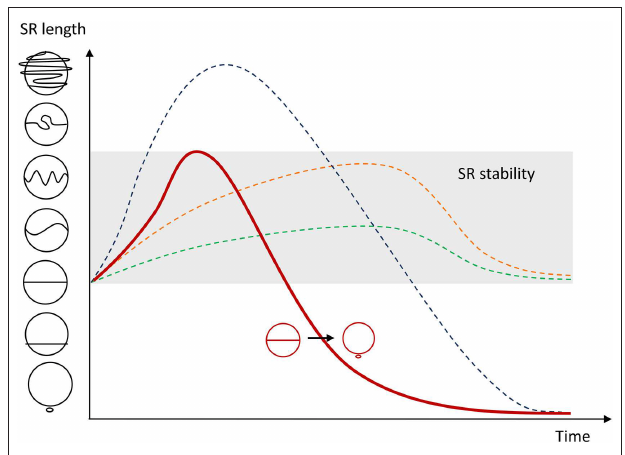
FIGURE 8 | The different dynamic configurations of the system are sketched and ordered in terms of the length of the SR, which determines the elastic energy landscape. The shaded region represents regimes with stable SR oscillations. Solid and dashed lines represent possible pathways in the evolution of the SR, as described in the text. At long times (ATP running out), the SR may either return to its equilibrium conformation or collapse into a